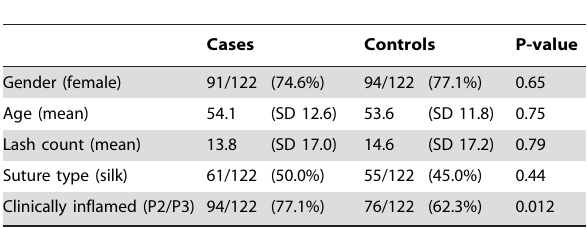
Table 2. Baseline demographic and clinical